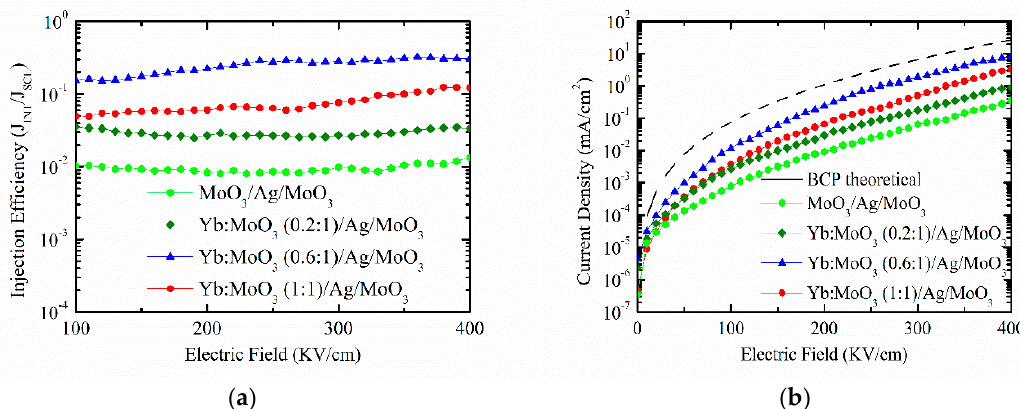
Figure 1. ( a ) Current density electric field characteristics, and ( b ) electron injection efficiency electric field characteristics of the electron-only devices with different Yb doping ratios in inner MoO 3 .